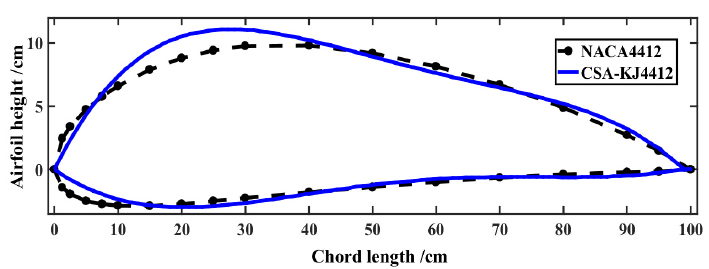
Figure 2. Airfoil shape before and after treatment.